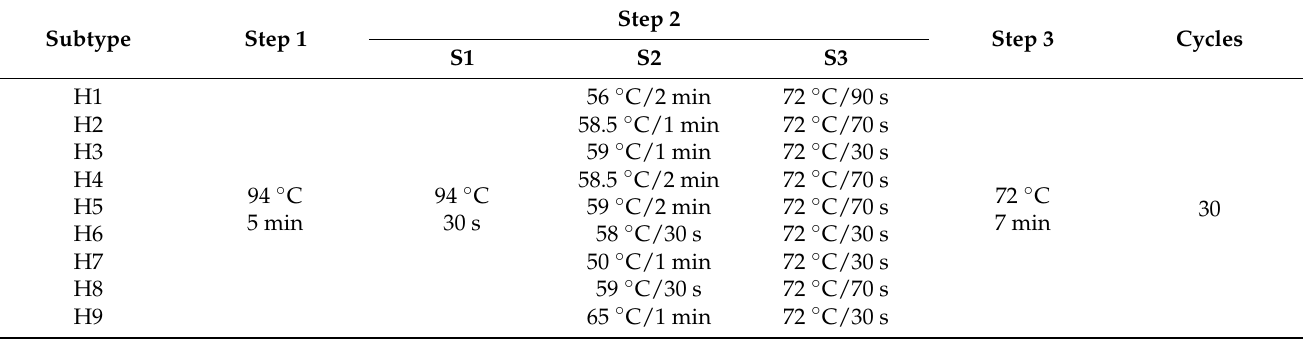
Table 4. PCR reaction